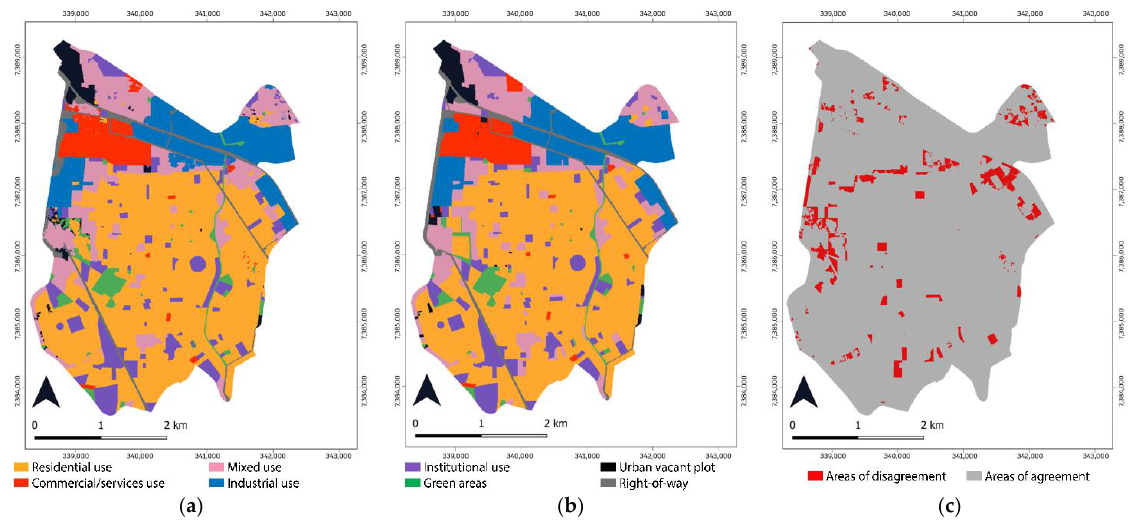
Figure 12. ( a ) 2018 simulated land use map without refined calibration, ( b ) 2018 real land use map, ( c ) areas of agreement and disagreement.